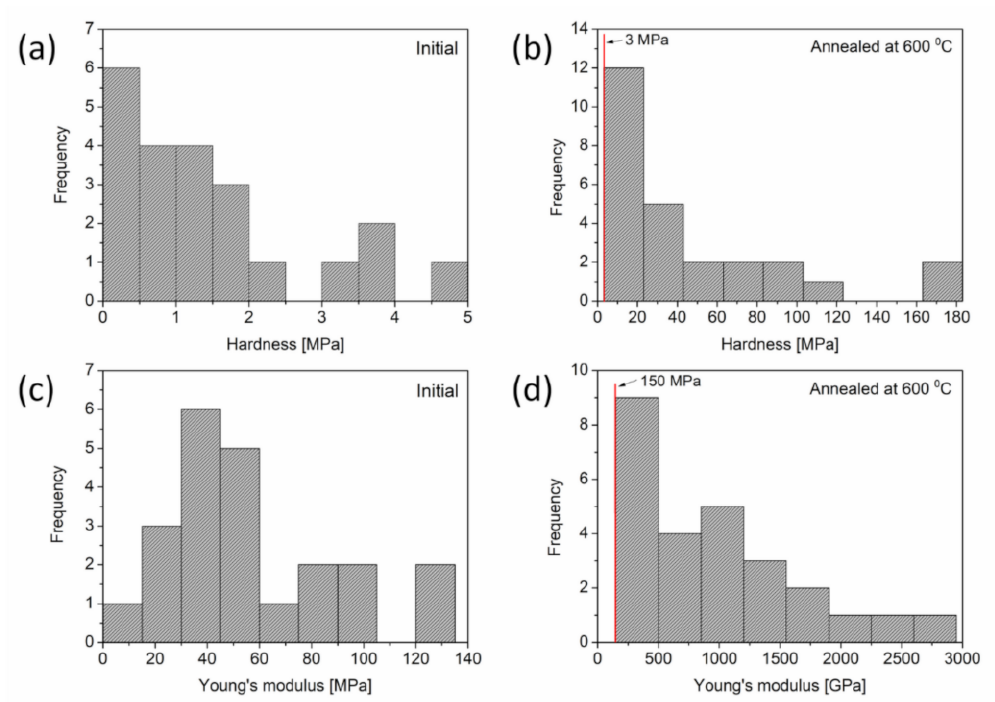
Figure 8. ( a , b ) Distributions of hardness and ( c , d ) Young’s modulus obtained by nanoindentation measurements conducted on Cu foams processed by ( a , c ) route C and ( b , d ) its counterpart annealed at 600 ◦ C for 5.5 h after